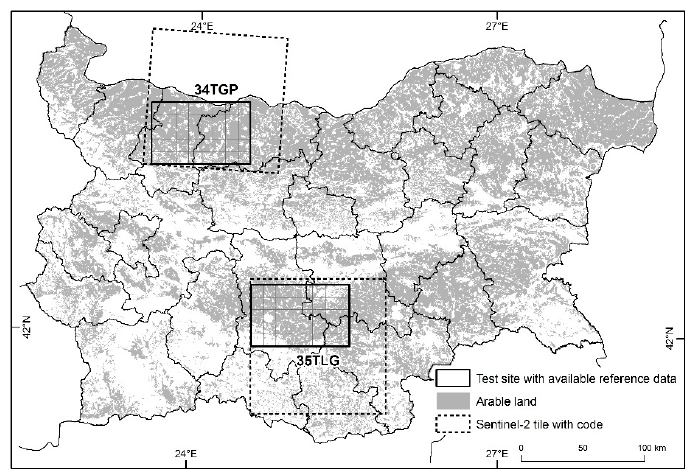
Figure 1. Location of the two test sites with available reference data in Bulgaria (Knezha to the north and Belozem to the south). The borders of the administrative units at Nomenclature of Territorial Units for Statistics level 3 are shown as well as the arable land (source: Corine Land Cover) and the corresponding Sentinel-2 tiles. Each test site was divided in artificial regions 10 × 10 km² for validation purposes (see the text for explanation).